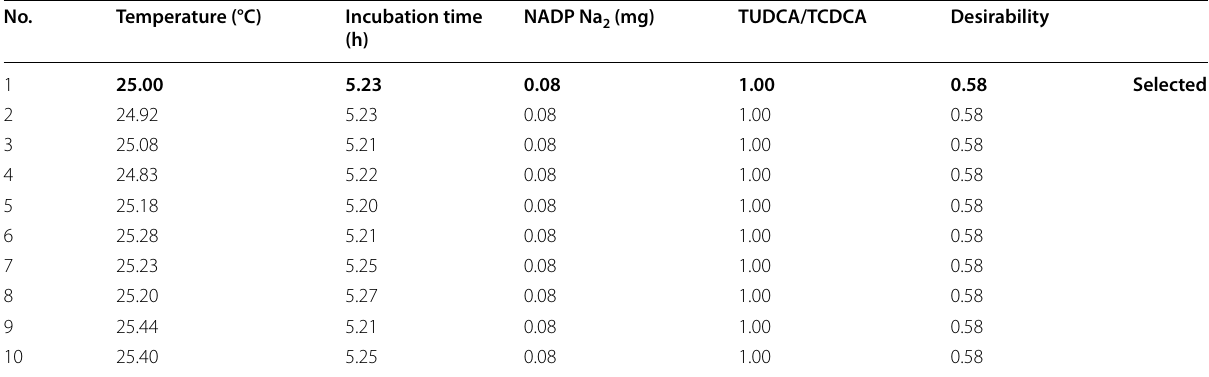
The top 10 of 32 solutions were listed and the selected one was highlighted in bold